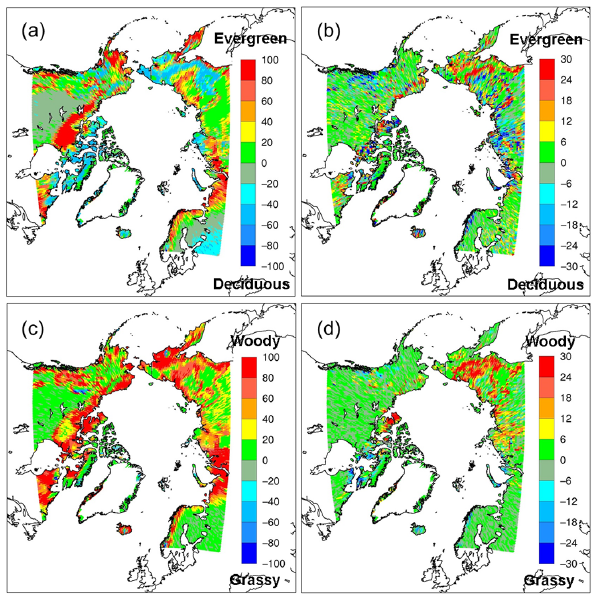
Figure 8. The percentage of change for normalized phenology in- dex(%) C NPI = ( LAI eg − LAI d )/( LAI eg + LAI d ) (Wramneby et al., 2010) quantified by the shift in the relative abundance between ever- green (eg) and deciduous (d) PFTs due to (a) climate change from the period 1961–1990 to the period 2071–2100; (b) the effects of biogeophysical feedbacks for the period 2071–2100. The percent- age of change for normalized physiognomy index (%) C NPMI = ( LAI w − LAI h )/( LAI w + LAI h ) quantified by the shift in the rela- tive abundance between woody (w) and herbaceous (h) PFTs due to (c) climate change from the period 1961–1990 to the period 2071– 2100; (d) the effects of biogeophysical feedbacks for the period